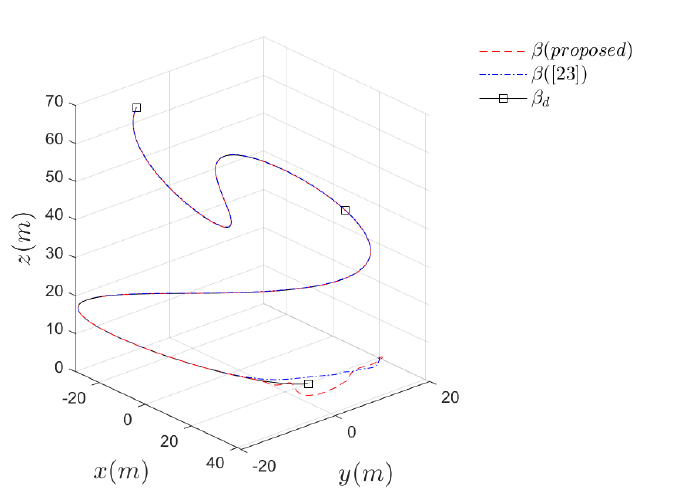
Figure 14. Comparison of tracking results of the proposed approach and the previous approach [23] in three-dimensional space for Scenario 3.